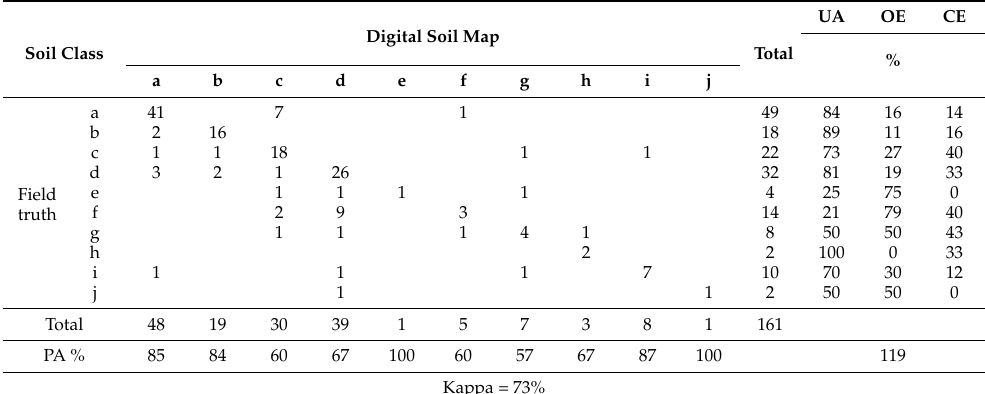
Table 4. Matrix errors between the field truth and the digital soil map classes from Ribeir ã o Extrema microwatershed (RE–target